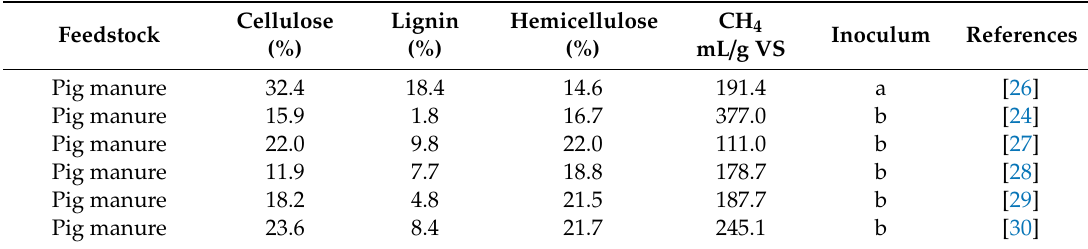
Table 1. Results of monodigestion of pig, cow and poultry manure with di ff erent fiber compositions.